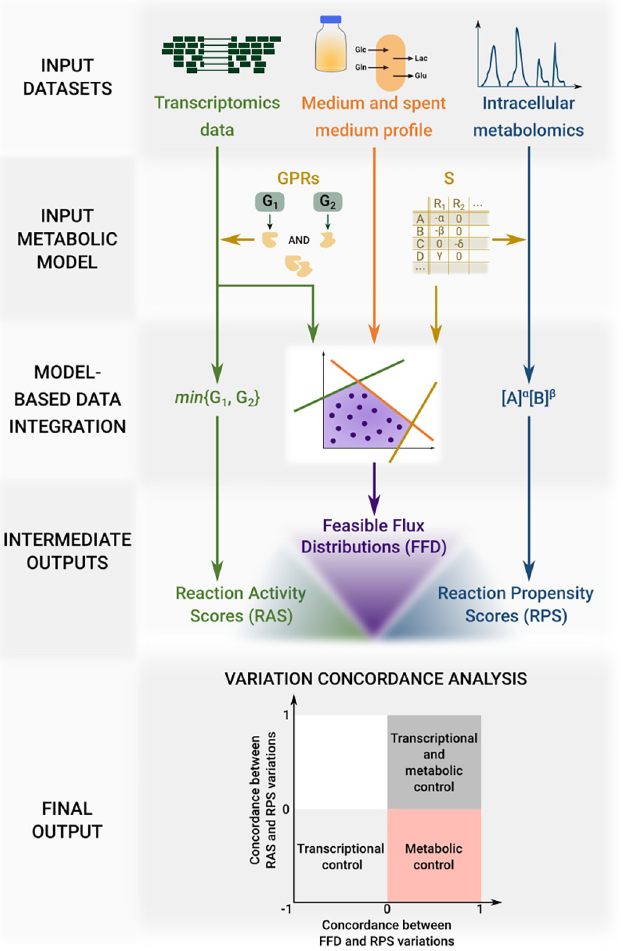
Fig 1. Graphical representation of INTEGRATE pipeline. Three heterogeneous experimental datasets are integrated into the input metabolic model to obtain three comparable datasets regarding transcriptomics, fluxomics and metabolomics. The concordance level between pairs of these intermediate output datasets is the final output of INTEGRATE.